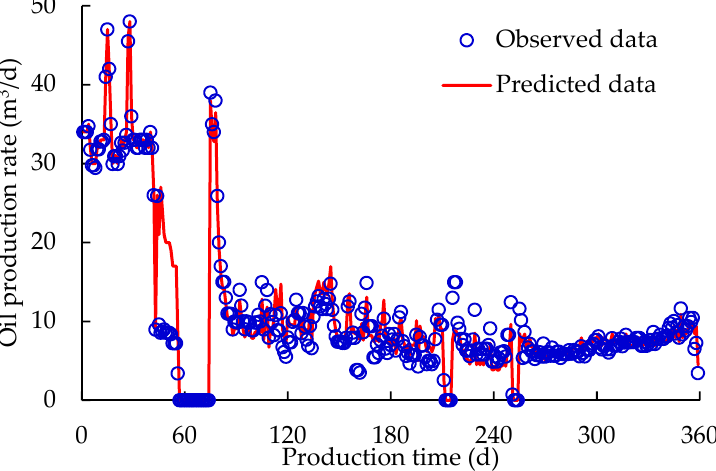
Figure 6. CRMIP oil production match for Pro_2.